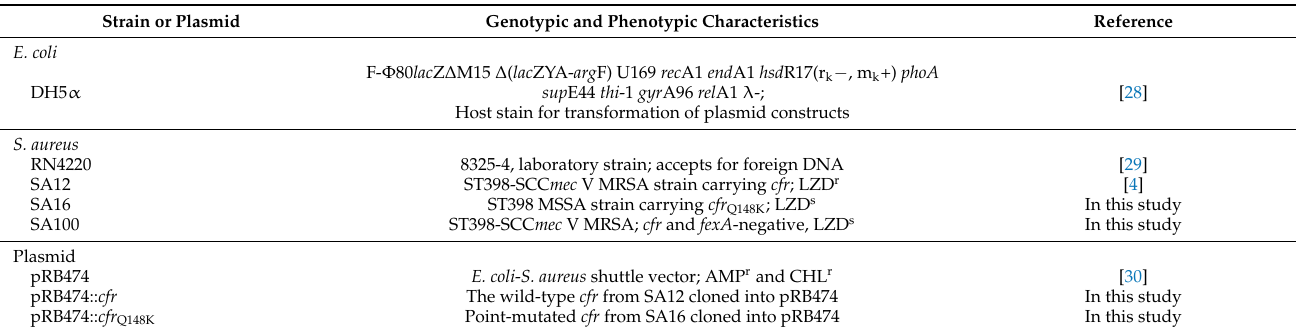
Table 2. Stains and plasmids used in this study.